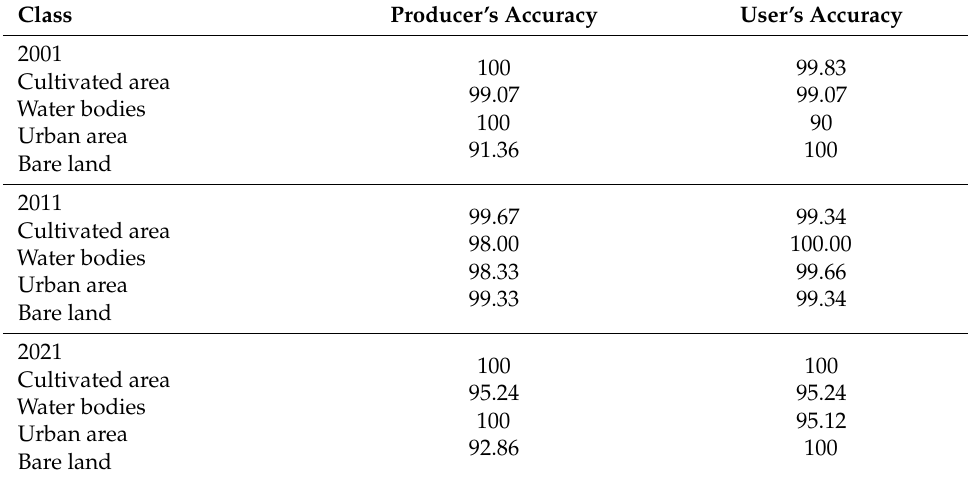
Table 1. The accuracy (%) for all images of (2001, 2011, and